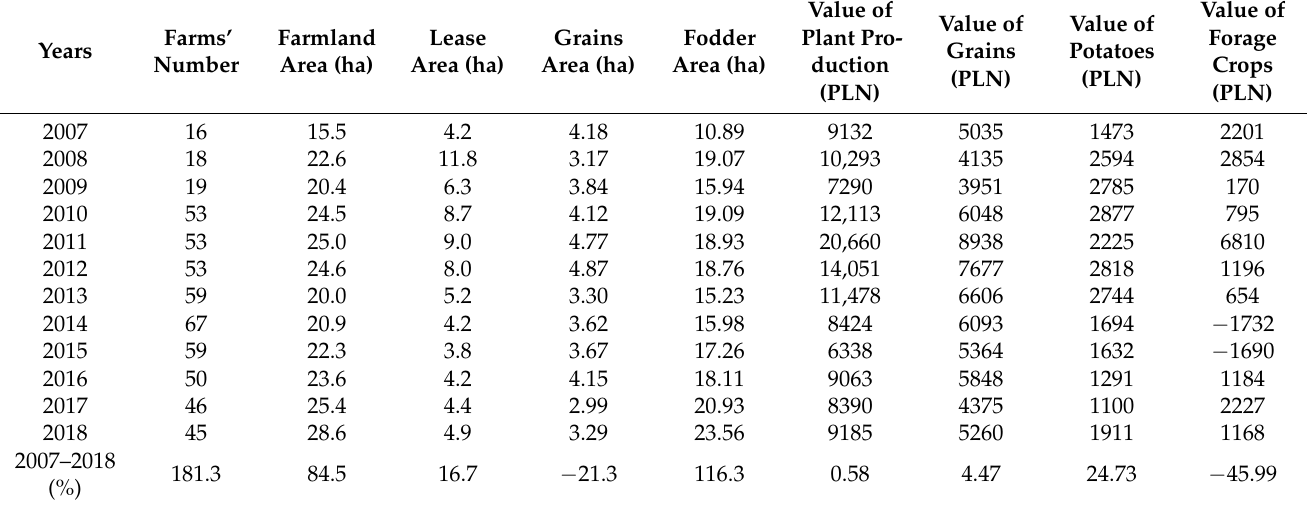
Table 6. Characteristics of plant production of dairy organic farms in Poland in